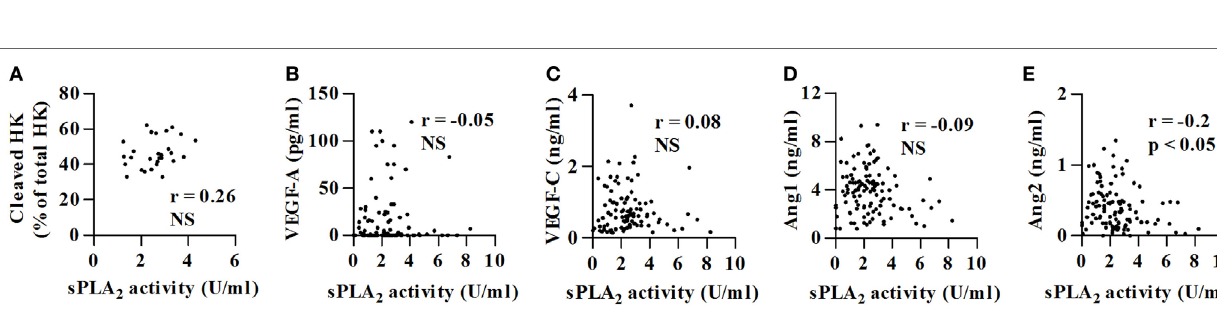
FigUre 2 | Correlations between sPLA 2 activity and complement components. sPLA 2 activity in patients with different functional activity of C1-INH. (a) Correlation between sPLA 2 and C1-INH activity was assessed by Spearman’s correlation analysis and reported as coefficient of correlation ( r ). (B) Patients were divided in two groups: C1-INH type I patients with less than 25 or 25–50% of normal C1-INH protein values. (c) Patients were divided in two groups: C1-INH-HAE patients with less than 25 or 25–50% of normal C4 values. Activity of sPLA 2 (B,c) is